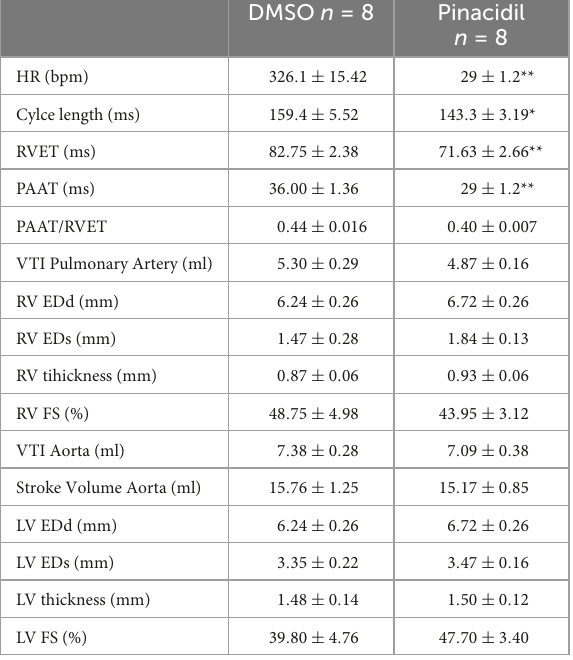
TABLE 1 Evaluation of right ventricular and left ventricular function by echocardiography measured in pinacidil or dimethyl sulfoxide-exposed rats.